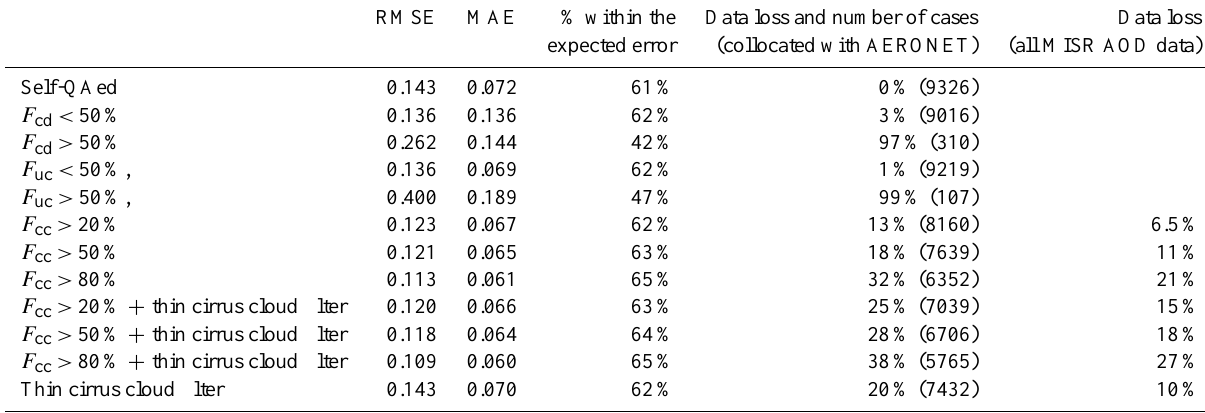
Table 2. Similar to Table 1 but for the over-land